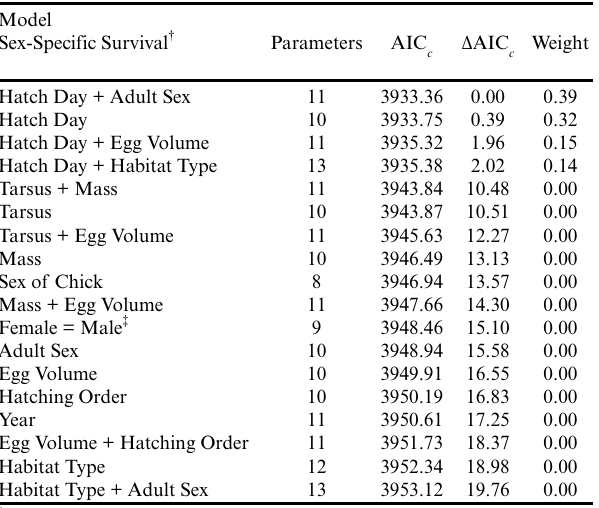
Table 1 . Summary of model selection results for Mountain Plover ( Charadrius montanus ) sex-specific chick survival in eastern Colorado from the 2010 to 2012 breeding seasons. Multistate mark-recapture models were used to compare differences in survival between male and female chicks. Fidelity, Φ , and detection probability of live recaptures and dead recoveries, p, were held constant for all models, thus omitted from the table. Models are presented in ascending order of Akaike’s Information Criterion (AIC ), with Δ AIC indicating the difference between c c each model and the model with the lowest AIC value and the c most AIC weight. Covariates used include hatch day (1 through c 68; day 1 = May 9), adult sex (sex of tending adult), egg volume, tarsus (length of tarsal bone), mass (chick mass at hatching), year, and habitat type (grassland, grassland with prairie dogs, and agricultural fields). “+” denotes the parameter had an additive effect of two covariates.